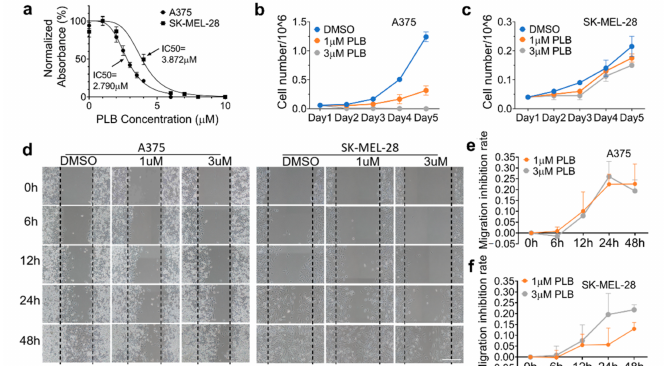
Figure 3. Differential inhibition effects of PLB on cell viability and migration in A375 and SK-MEL-28. ( a ) A375 and SK-MEL-28 cells were seeded in the 96-well plate at the density of 1 × 10 4 cells/well and treated with PLB (DMSO and 1, 2, 2.5, 3, 3.5, 4, and 6 µ M PLB for A375 cells; DMSO and 1, 2, 4, 6, 7, 8, and 10 µ M PLB for SK-MEL-28 cells) for two days. Viable cell numbers were measured by MTS assay. The IC50 of A375 and SK-MEL-28 cells were 2.790 and 3.872 µ M, respectively ( n = 3). ( b ) A375 cells and ( c ) SK-MEL-28 cells treated with DMSO and 1 and 3 µ M PLB were counted for 5 days ( n = 2). ( d ) Two cell lines were seeded in a 6-well plate, and the migration status was displayed by different treatments (DMSO and 1 and 3 µ M PLB) and time points (0, 6, 12, 24, and 48 h). The migration inhibition rates in the 1 and 3 µ M PLB groups were compared with the DMSO group. Scale bar = 0.1 mm. ( e ) Migration inhibition rate of A375 cells. ( f ) Migration inhibition rate of SK- MEL-28 cells ( n = 3). Results are expressed as mean ± SD. MTS, nonradioactive cell proliferation assay; IC50, 50% inhibitory